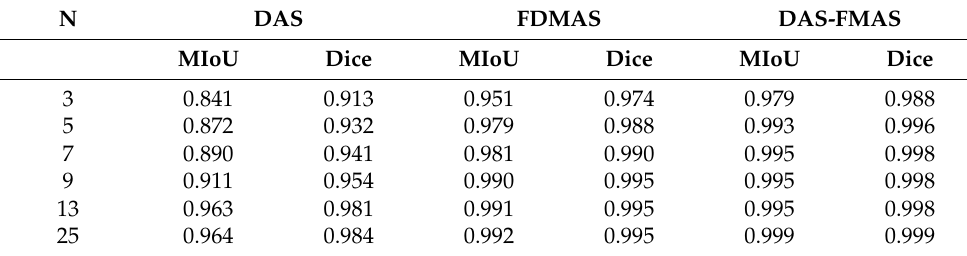
Table 4. BSAC segmentation